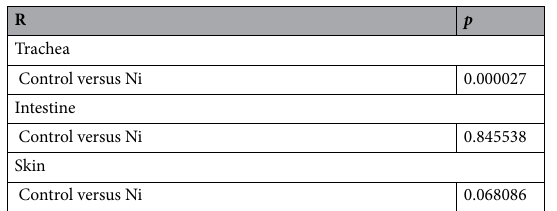
Table 4. Results of the Mann–Whitney test ( p < 0.05) for transepithelial electric resistance measured during stationary conditions (R) for the tissue specimens. Control—the specimens incubated in the bumetanide